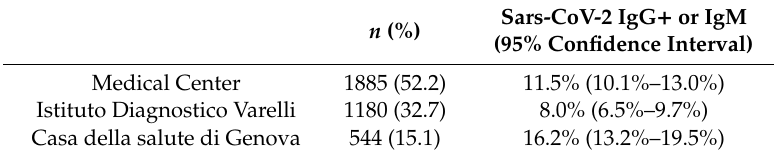
Table 2. Prevalence of SARS-CoV-2 IgM and IgG antibodies according to the three di ff erent laboratories.